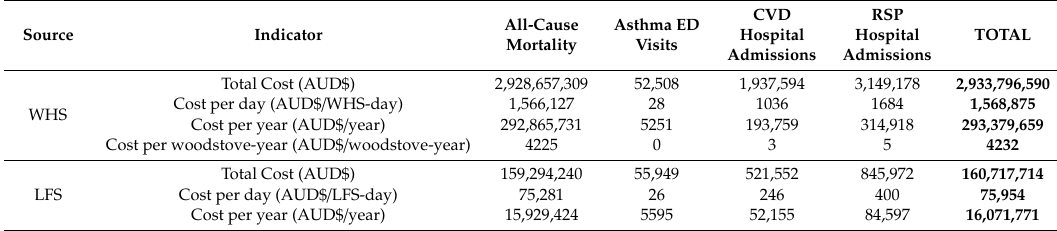
Table 7. Health economic impacts associated with biomass smoke for WHS and LFS between 2010 and 2019.